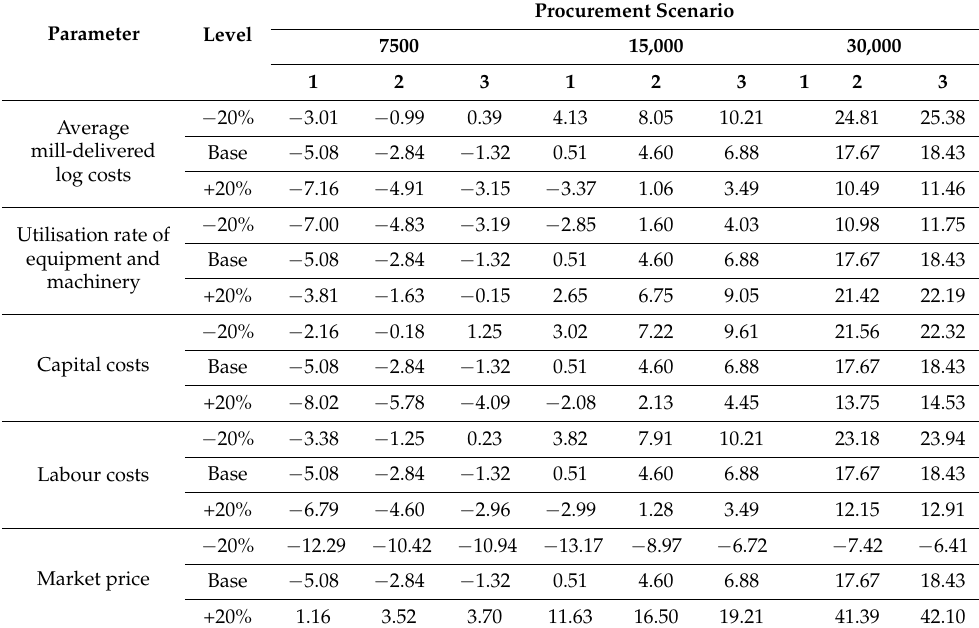
Table A3. Sensitivity of NPV of one-stage LVL manufacture to changes in levels of several important model parameters at facility location